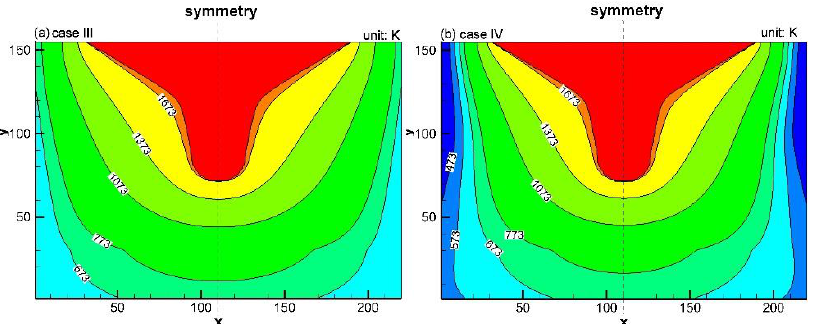
Figure 8. Temperature distribution in the trough materials near the end of a unit campaign cycle: ( a ) without the water cooling device and ( b ) with the water cooling device.